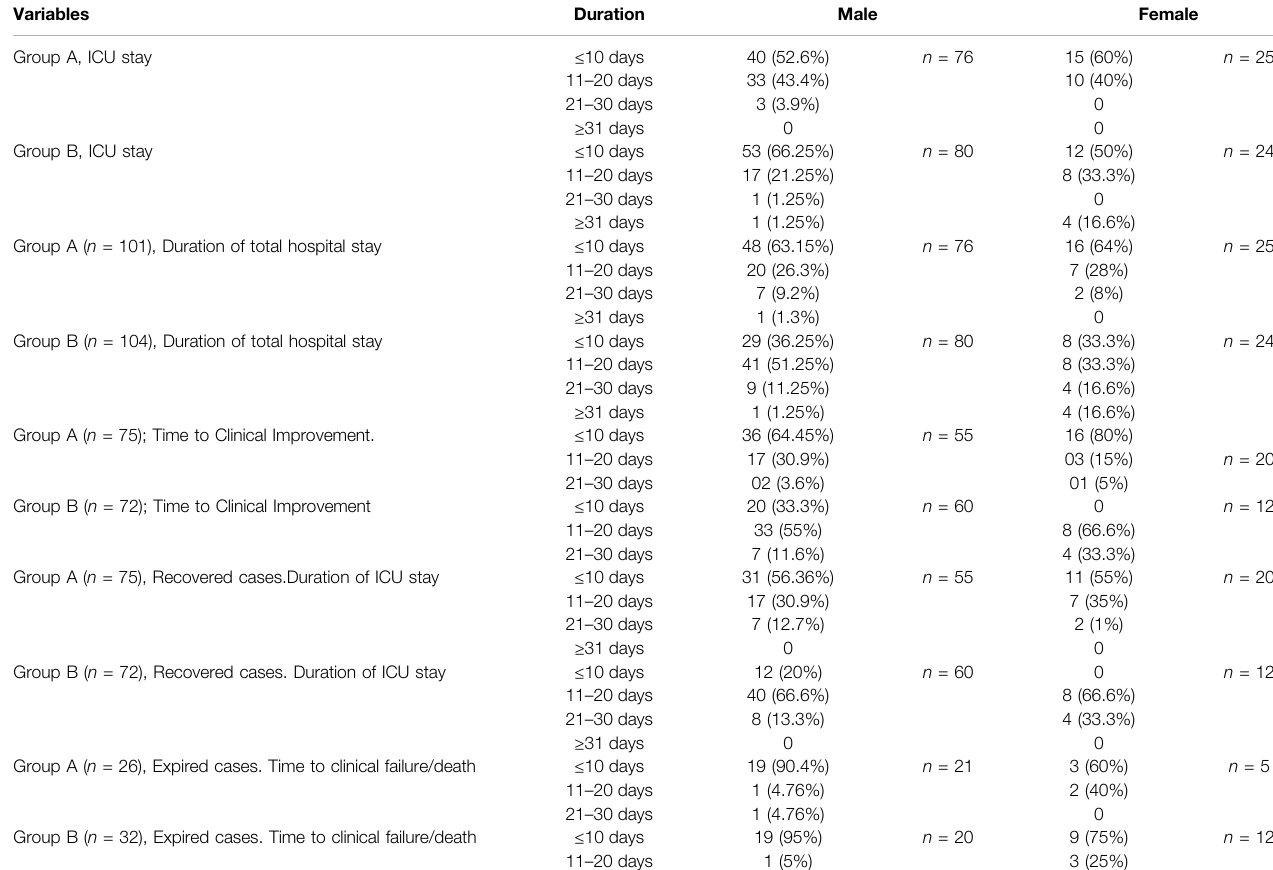
TABLE 2 | Subgroup analysis according to the gender and the duration of COVID-19 illness. Variables Duration Male Female Group A, ICU